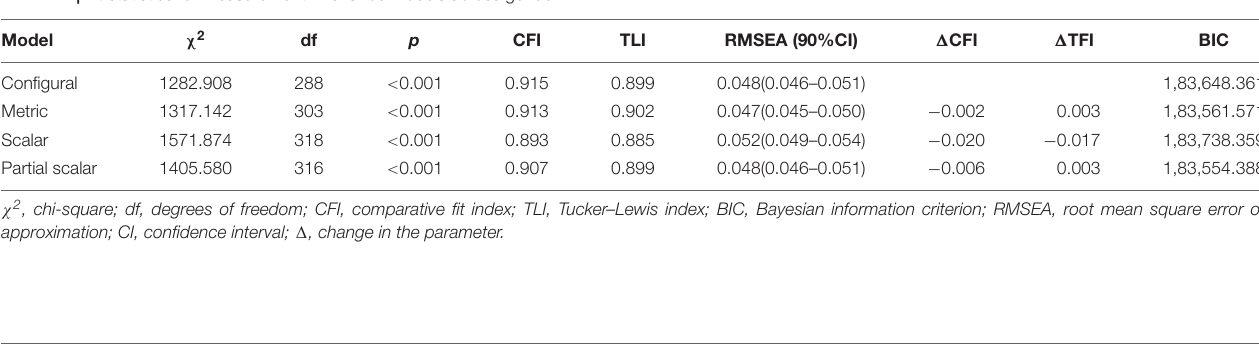
TABLE 7 | Fit statistics for measurement invariance models across